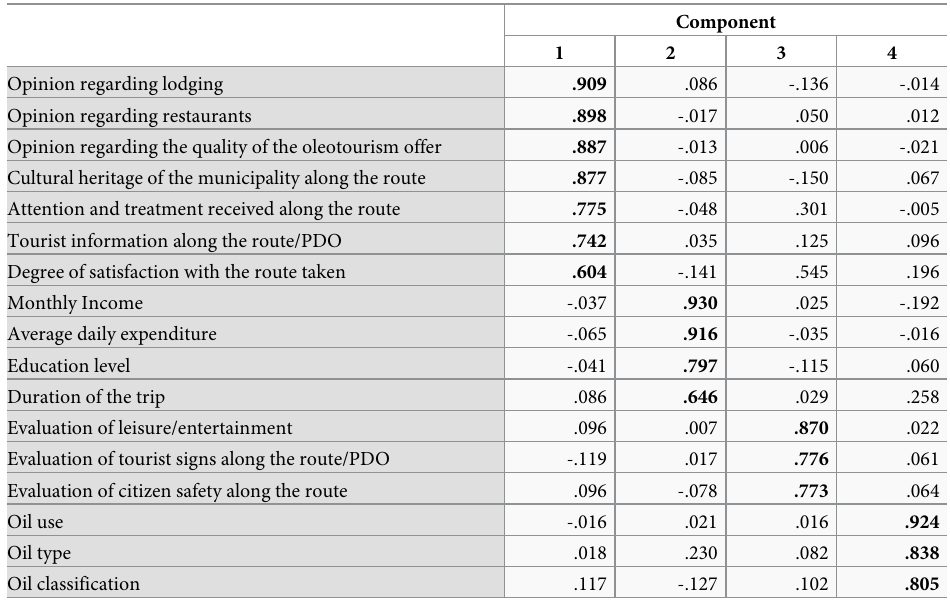
Table 5. Rotated a component